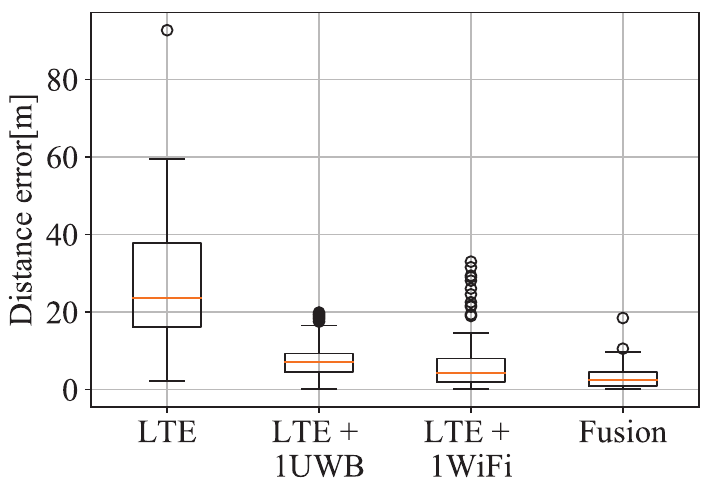
Figure 7. Horizontal error distribution of LTE and fusion for Case